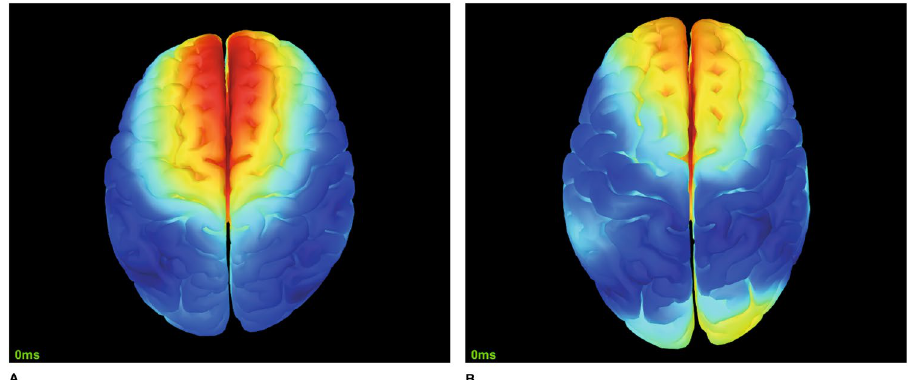
Figure 4. Typical evoked responses for ( A ) KI (subject 1) and ( B ) VI (subject 3). The activity in the frontal cortex for KI subjects is suppressed during MI.